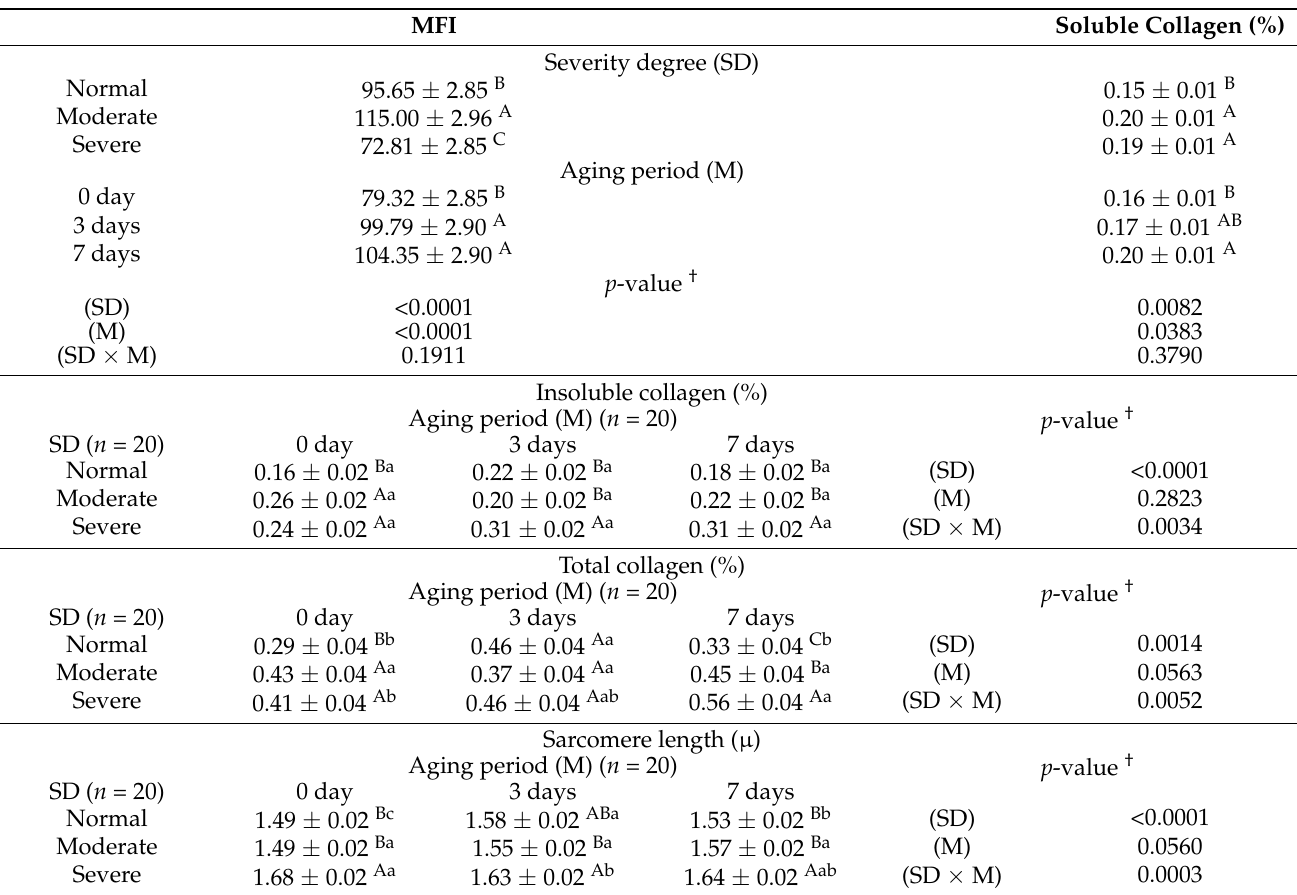
Table 4. Mean values of myofibrillar fragmentation index (MFI); soluble, insoluble, and total collagen; and sarcomere length of breast meat from broilers affected by wooden breast myopathy maturated for up to 7 days.